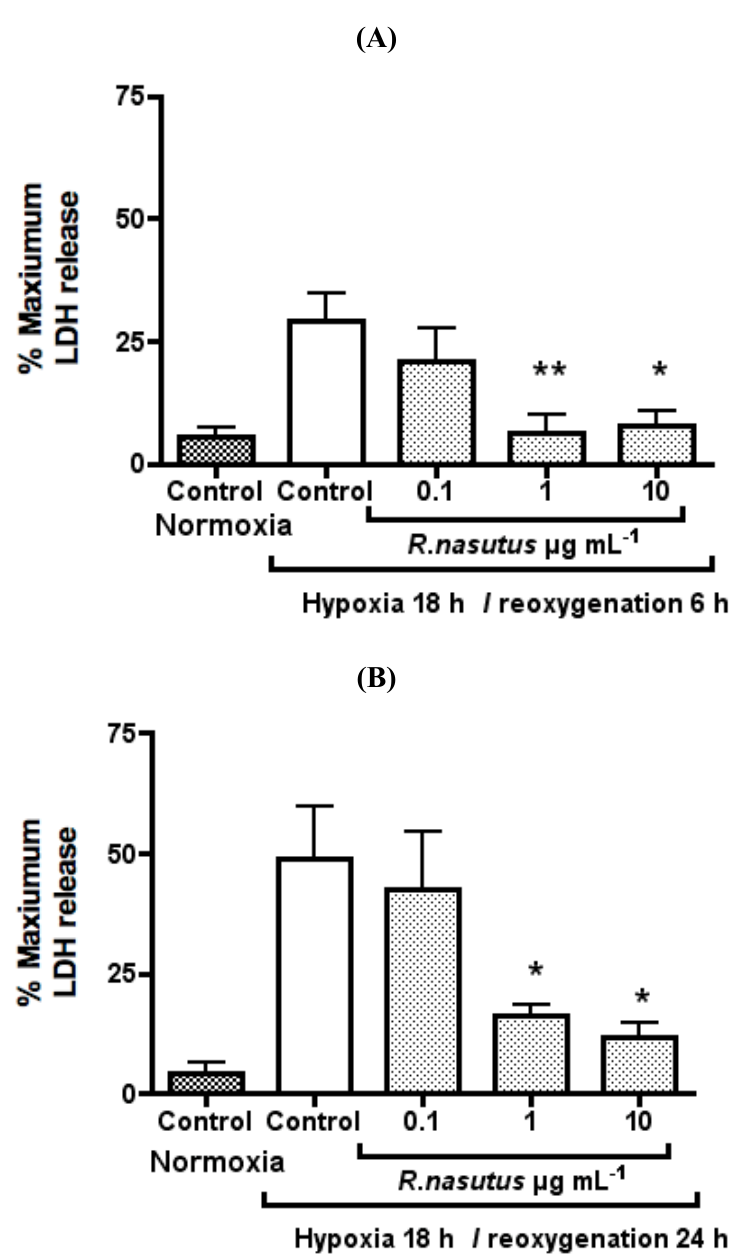
Figure 6. LDH release from HT-22 resulting from being subjected to 18 hours of hypoxia and 6-hours of reoxygenation ( A ) ( n = 5) or 24-hours rexoygenation ( B ) ( n = 3) *